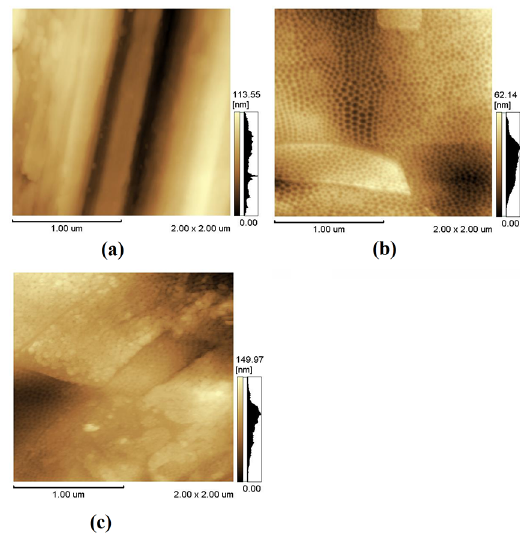
Figure 3. Atomic force microscopic 2D images of the samples used to grow hESCs-MP in non-osteogenic media. (a) Mechanically polished sample; (b) Electropolished sample that was treated for 4 min; and (c) Electropolished sample that was treated for 12 min.